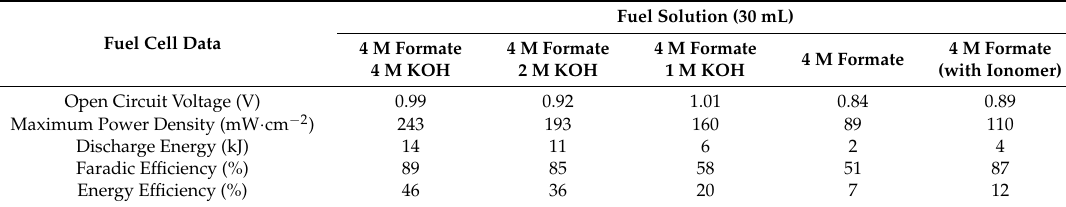
Table 1. Fuel cell data for DFFCs with single fuel load (MEA; Pd/C-CeO 2 anode, FeCo/C cathode, AEM A-201 (T cell 60 ◦ C)).